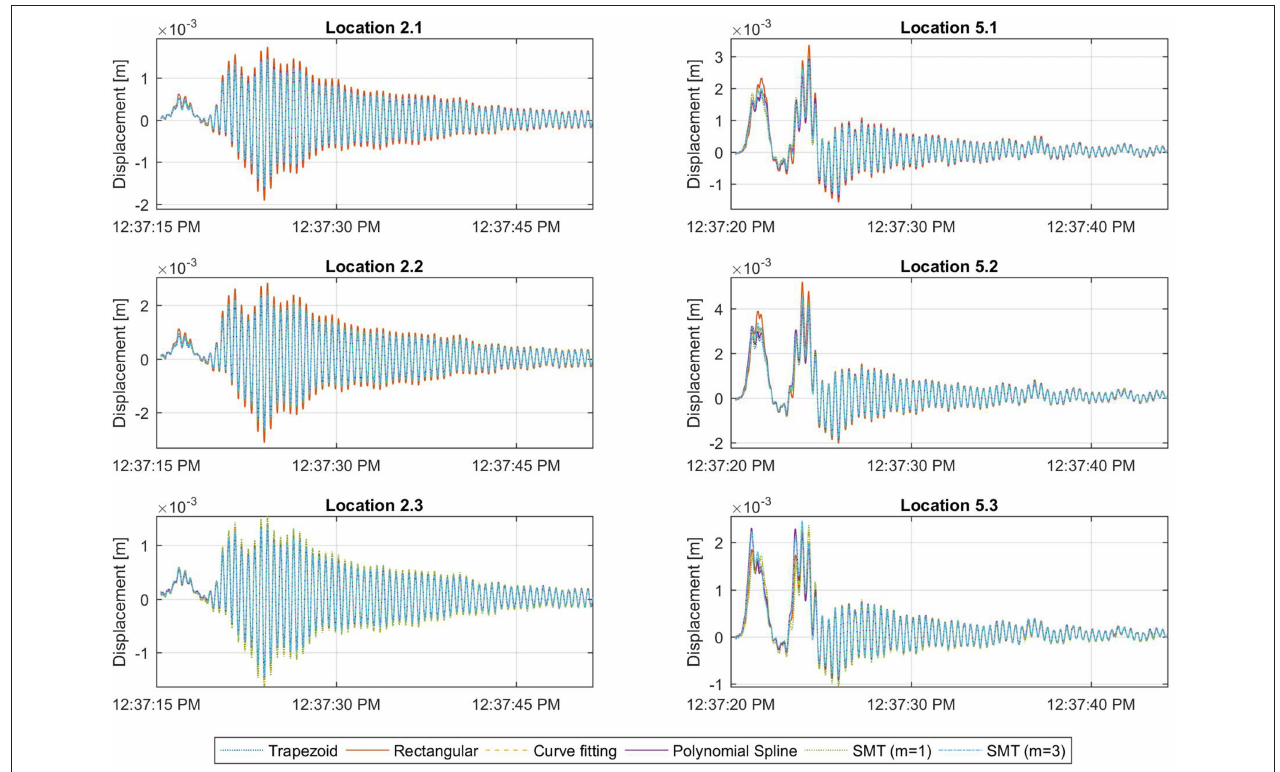
FIGURE 13 | Displacement estimation at girders 2 and 5 from strain response due to service loads on the bridge.